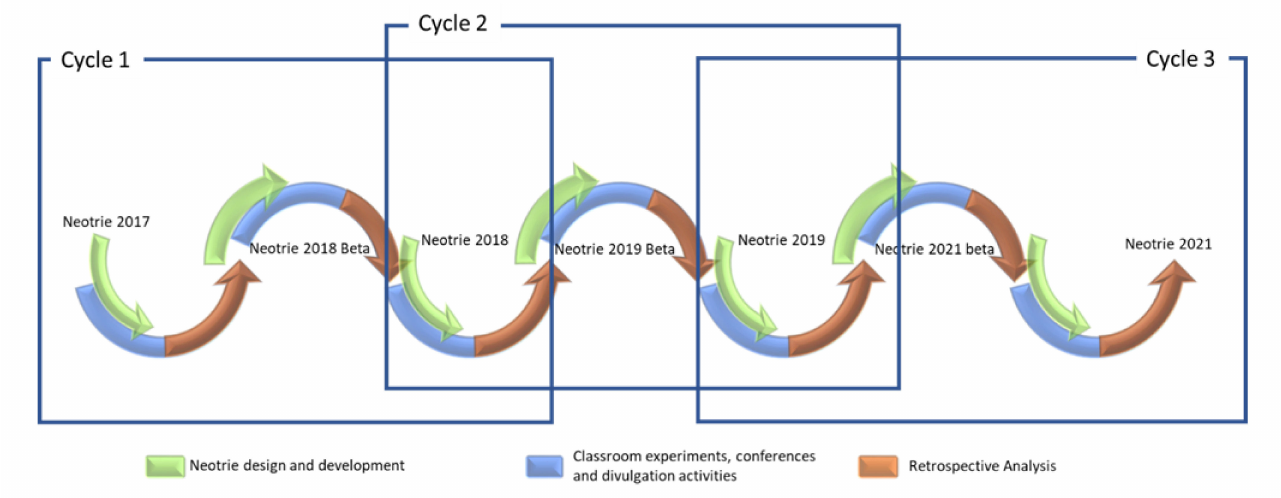
Figure 7. Development